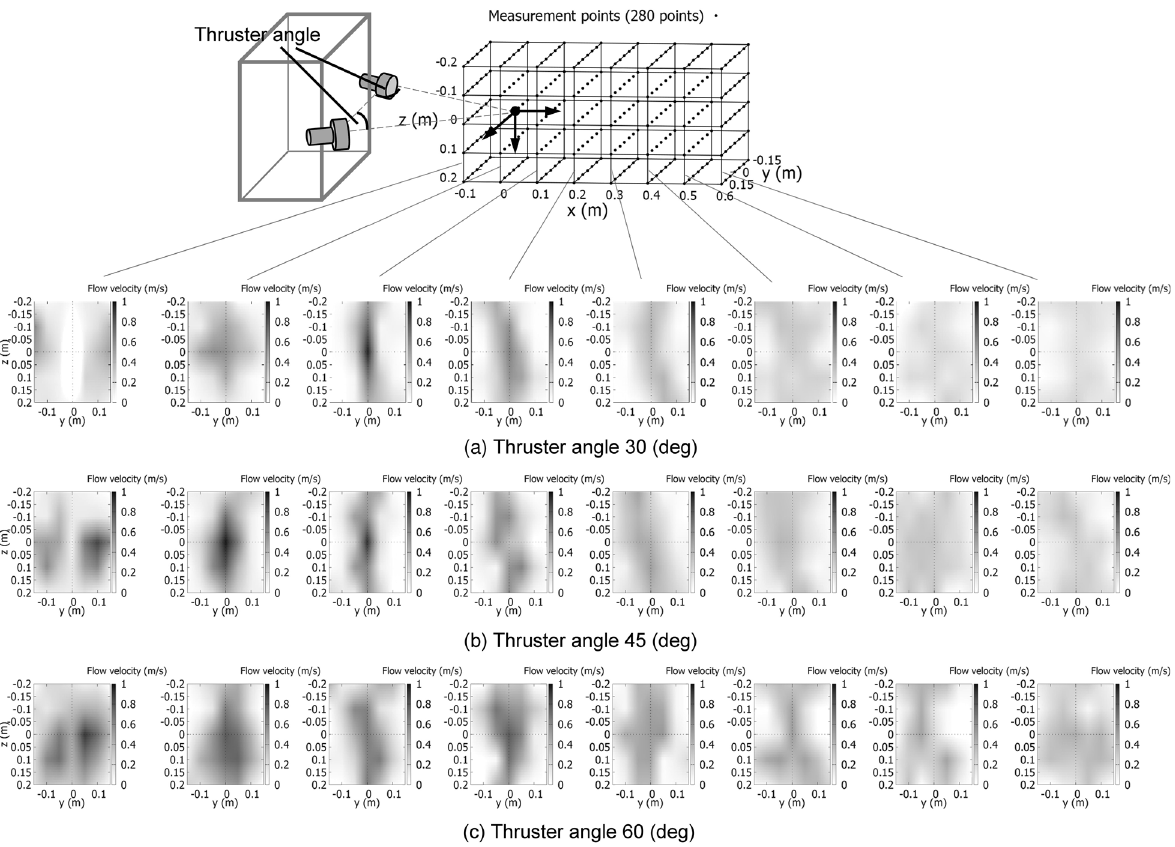
Fig. 4 Experiment results show the vertical distribution for three thruster angles